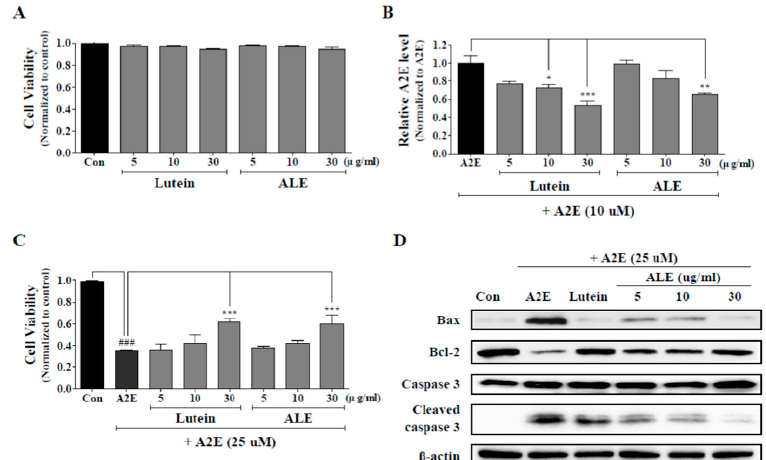
Figure 4. Protective effects of ALE on A2E accumulation and A2E-induced cell death in ARPE-19 cells. ( A ) Cell viability of ARPE-19 cells treated only with lutein or ALE. ARPE-19 cells were incubated with lutein or ALE (5, 10, 30 µ g / mL) for 24 h and the cell viability was measured using the CCK-8 kit. ( B ) Inhibition of intracellular A2E accumulation by ALE pretreatment. ARPE-19 cells were treated with ALE (5, 10, and 30 µ g / mL) on days 2, 5, and 8, and with A2E (10 µ M) on days 3, 6, and 9. On the last day (day 10), A2E in ARPE-19 cells was extracted, analyzed by HPLC, quantified using an external A2E standard curve, and normalized to protein level. The values represent the mean ± SD ( n ≥ 3). * p < 0.05, ** p < 0.01, *** p < 0.001 vs A2E group, one-way ANOVA with Tukey’s post hoc test. ( C ) Inhibition of A2E-induced cell death by ALE pretreatment. ARPE-19 cells were incubated